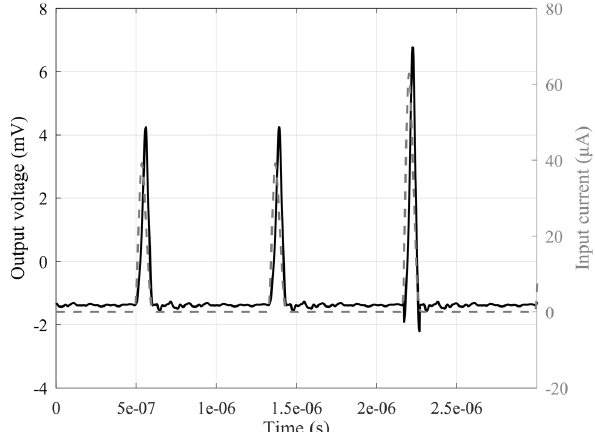
Figure 15. Output voltage signal of the circuit (black trace, left axis) when considering a current pulse train with different amplitudes and repetition time (grey trace, right axis). Table 1. Comparison with different literary solutions.